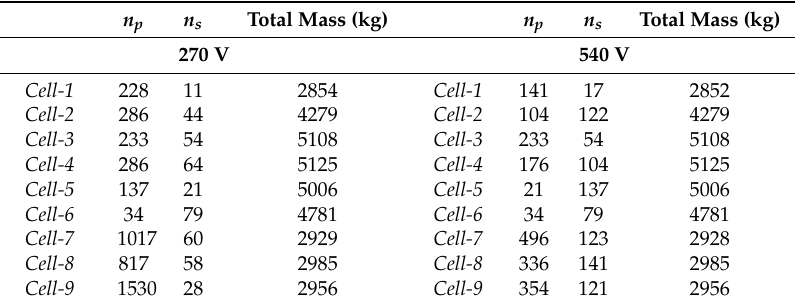
Table 9. Engine3_SFCmin.